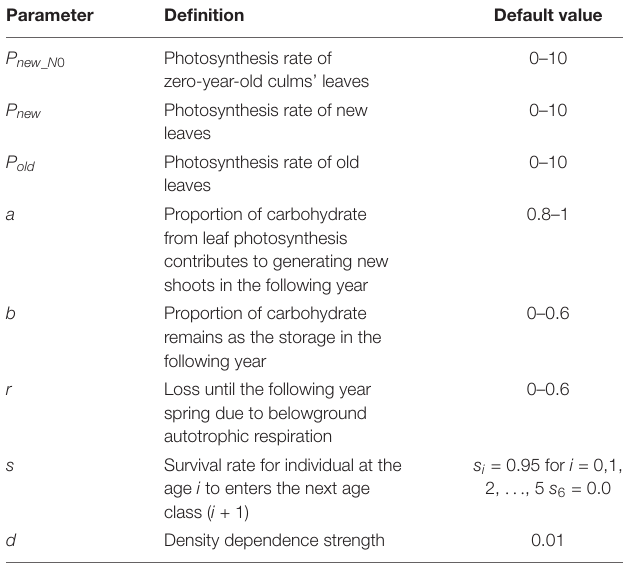
TABLE 1 | List of parameters for the age-structured population growth